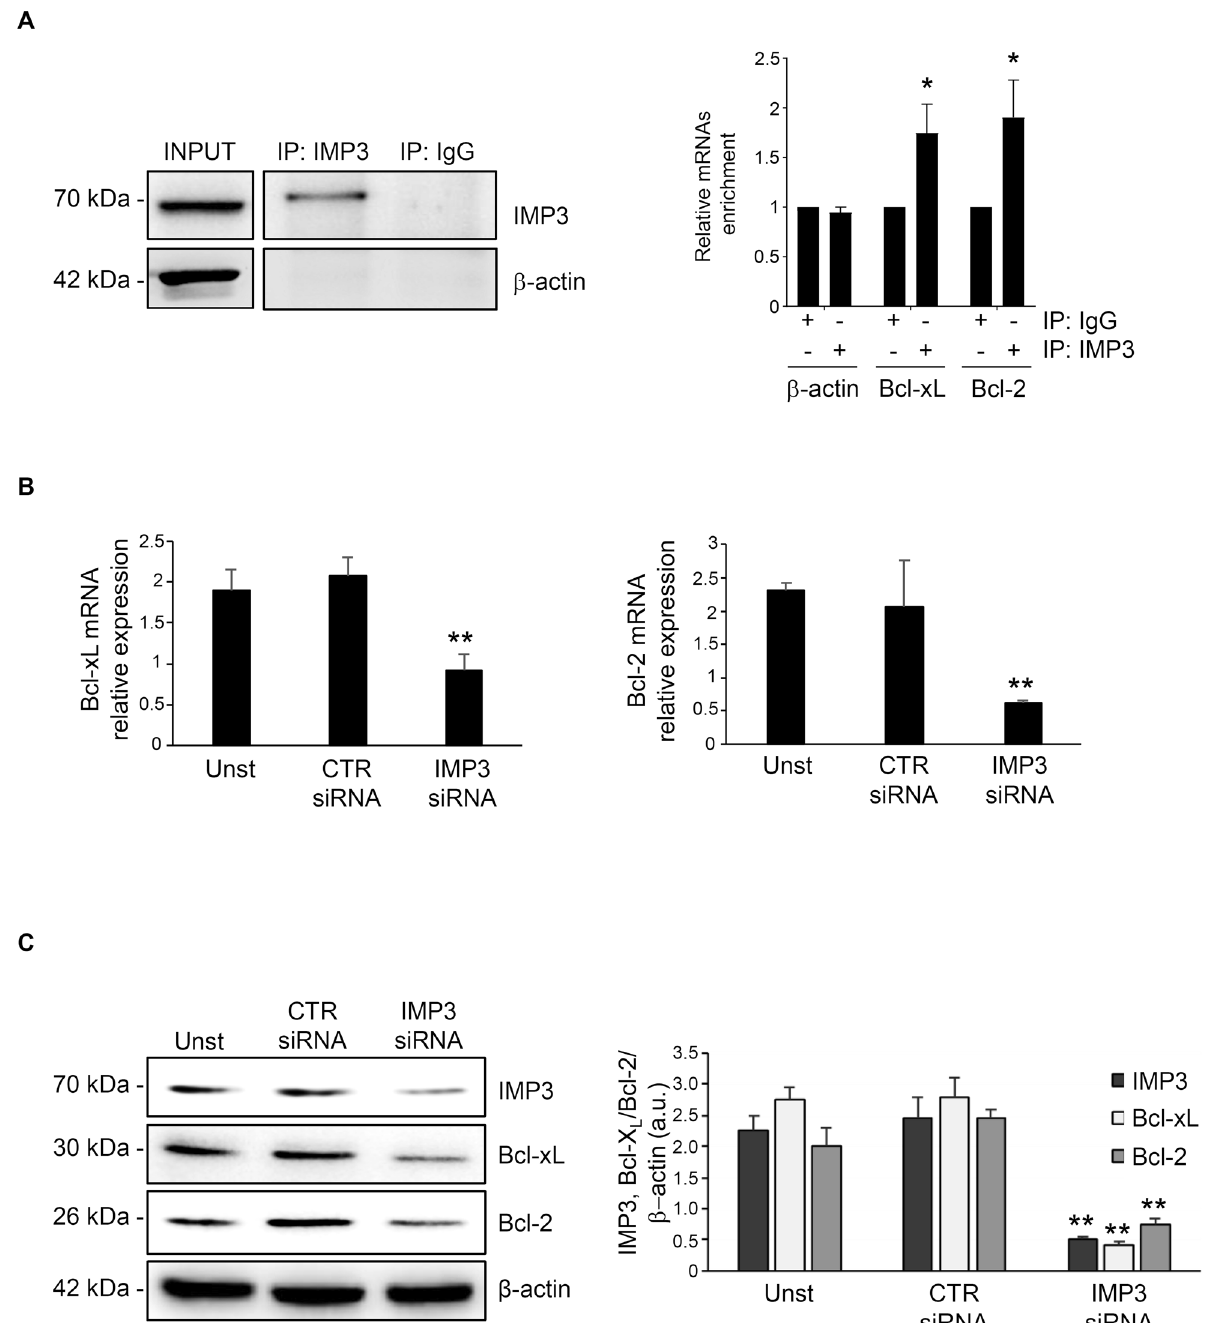
Fig. 5 Bcl-2 and Bcl-xL mRNA are part of the IMP3 complex. A Left, representative Western blot of IMP3 immunoprecipitation from HCT-116 cells, β -actin is used as a negative control. Input (1:10) of the total protein extracts, IMP3 immunoprecipitation (IP: IMP3), and mock immunoprecipitation (IP: IgG). Right, relative quanti fi cation of IMP3-mRNAs enrichment by RT-qPCR in IMP3 immunoprecipitation/total protein extracted from HCT-116 cells . β -actin mRNAs were used as control (mean ± SEM; IP: IMP3 versus IP: IgG * P ≤ 0.05; n = 3). B Bcl-xL and Bcl-2 mRNA levels detected by Real time PCR in HCT-116 cells left untreated (Unst) or transfected with CTR or IMP3 siRNA for 30 h. Unst and CTR siRNA-treated cells versus IMP3 siRNA-transfected cells, ** p ≤ 0.01; n = 3). C Representative Western blot showing IMP3, Bcl-xL, Bcl-2 and β -actin in HCT-116 cells were left untreated (Unst) or transfected with control or IMP3 siRNA for 36 h. Right, quanti fi cation of IMP3, Bcl-xL and Bcl-2 proteins in HCT-116 cells as measured by densitometry of Western blot (values are expressed in arbitrary units (a.u.), mean ± SD, n = 4; IMP3: Unst and CTR siRNA-treated cells versus IMP3 siRNA-transfected cells, ** p ≤ 0.01; n = 3). Bcl-xL siRNA alone or in combination showed an increased with Bcl-2 and Bcl-xL downregulation at mRNA and protein levels susceptibility to spontaneous cell death (supplementary Fig. 5A). (Fig. 5B, C). To further con fi rm that pro-survival function of IMP3 Conversely, HCT-116 overexpressing Bcl-2 and/or Bcl-xL showed in CRC cells is mediated by Bcl-2 and Bcl-xL expression, we an increased resistance to IMP3 siRNA-induced cell death explored the impact of down-regulating or over-regulating Bcl-2 (supplementary Fig. 5B). Our fi ndings indicate a pro-survival and Bcl-xL on cell death. HCT-116 cells treated with the Bcl-2 or Cell Death and Disease (2023)